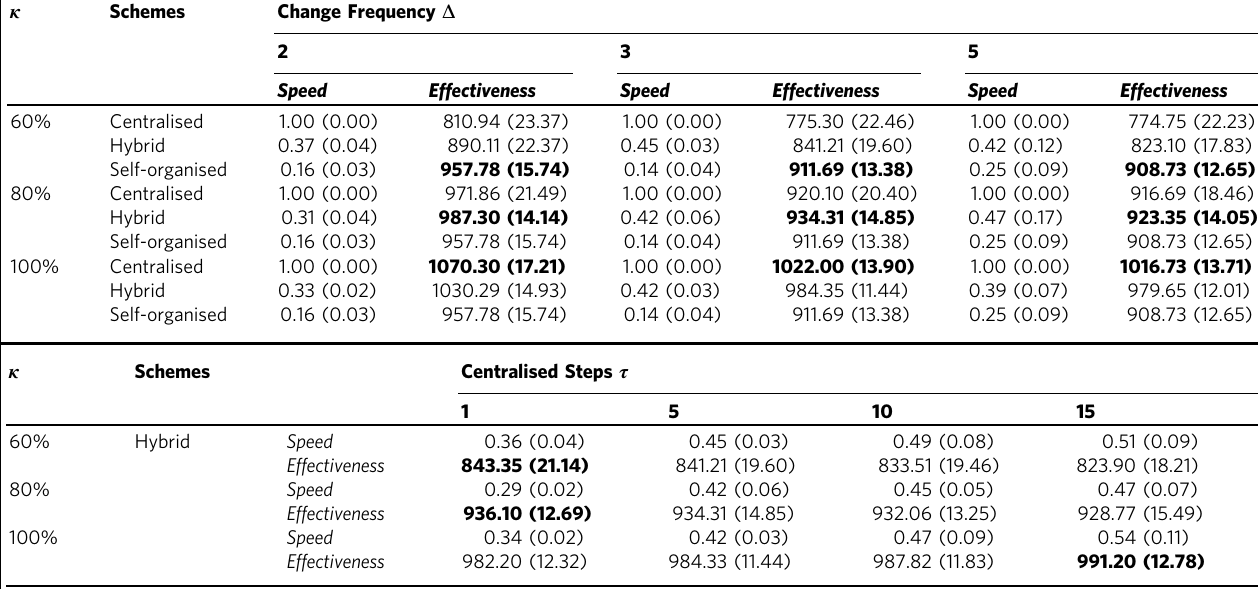
Top: Comparison among three organisation schemes under different observable demand rates κ and change frequency Δ . Bottom: The impact of centralised steps τ in the hybrid scheme under different κ